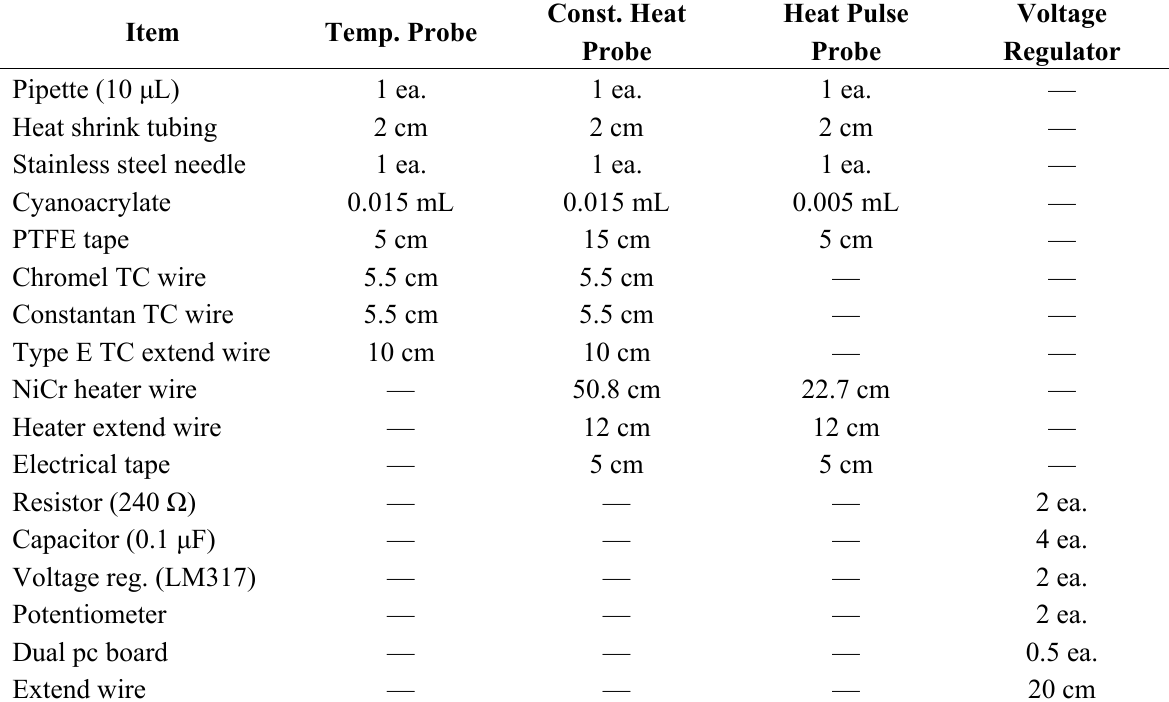
Table 1. Material quantities for a temperature probe, constant heat probe, heat pulse probe and voltage